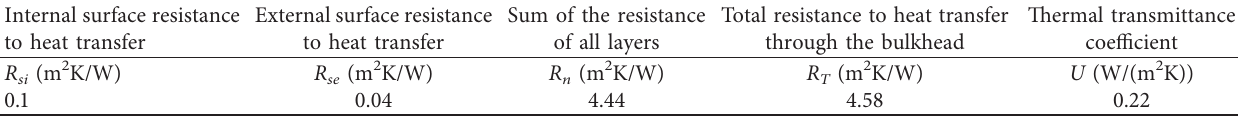
Table 4: Thermal transmittance coefficient—conventional flat roof (the table is structured by authors upon data from cost estimate and [41]).